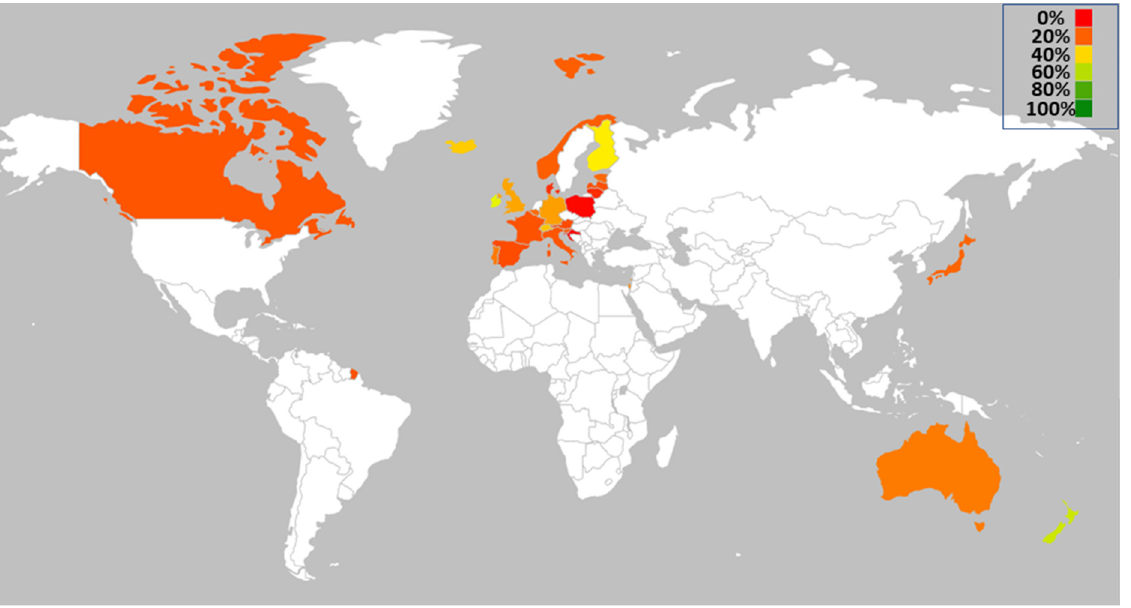
Figure 1. Level of adoption of the CT systems (%) in the 30 countries that made the download CT app data available.